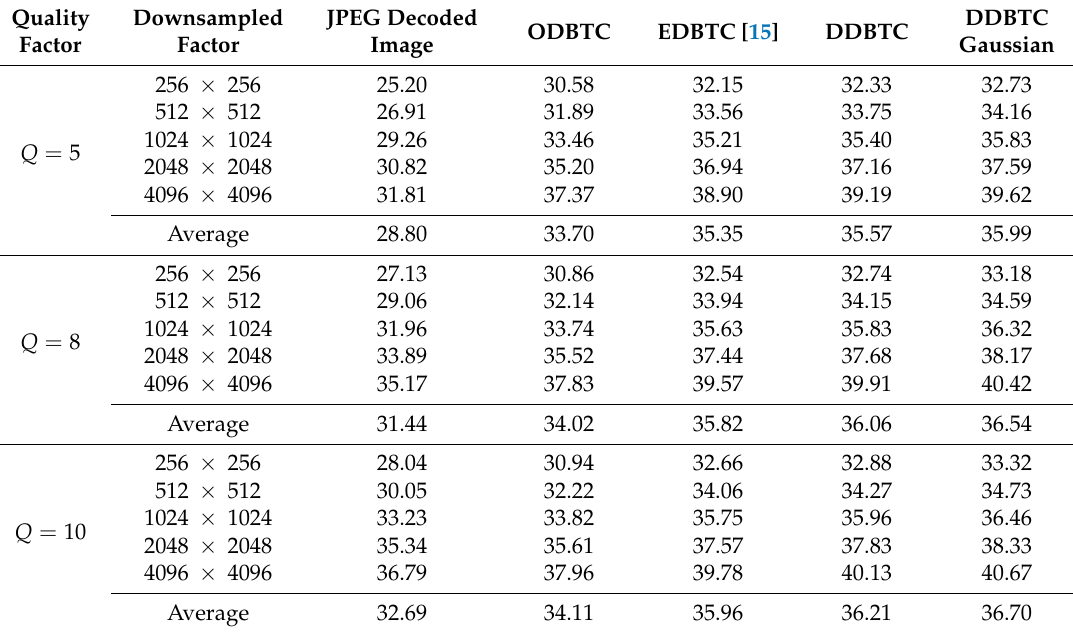
Table 3. PSNR Comparison on Image Set